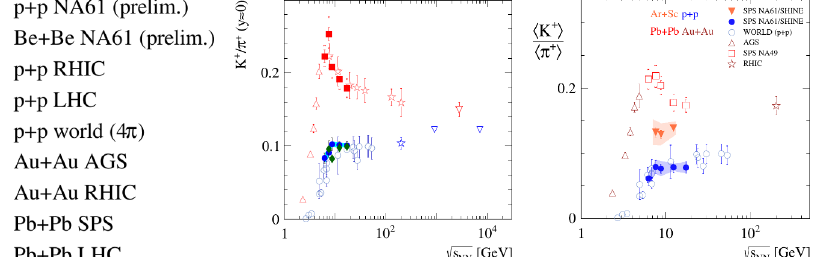
Figure 1. The so-called phase diagram of strongly interaction matter ( right). The onset of deconfinement takes place in the early stage when the transition line is crossed ( left).